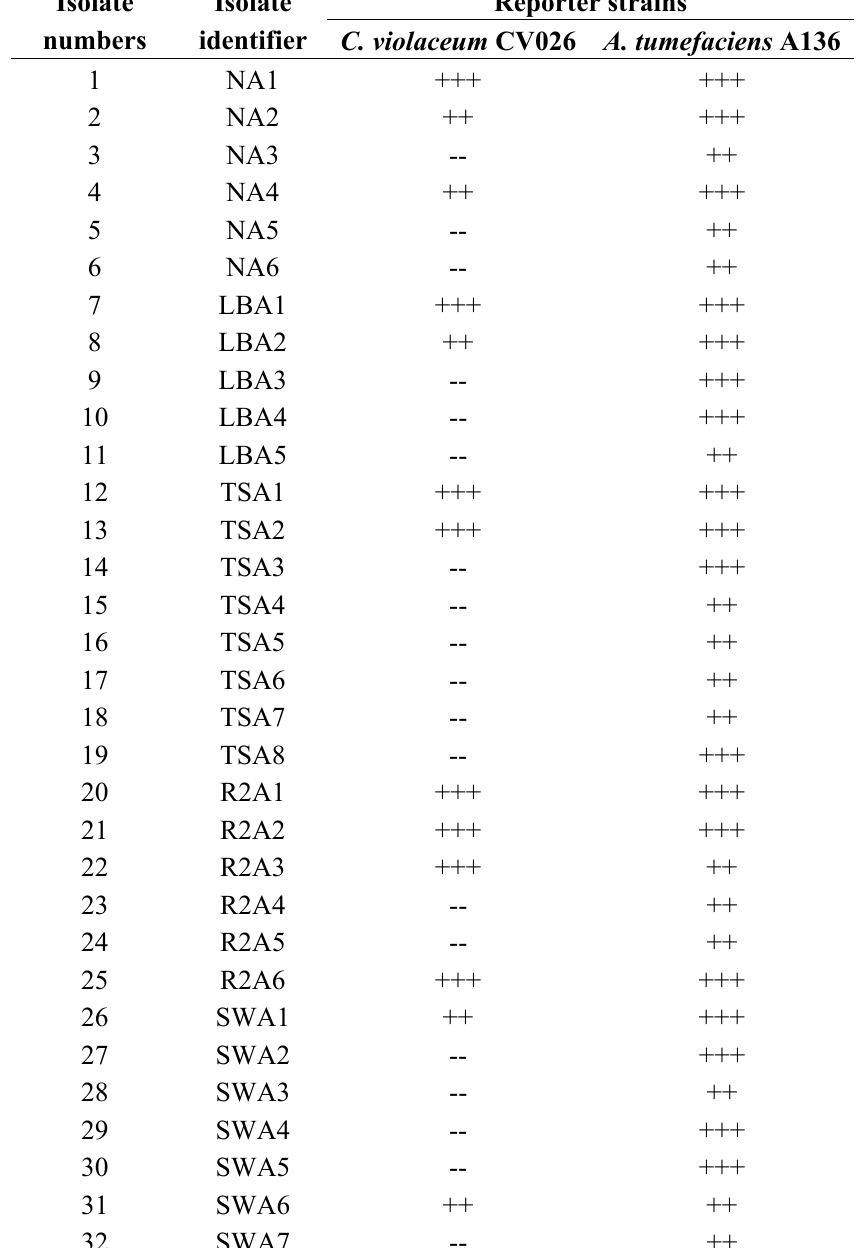
Table 1. Screening of bacterial isolates for AHLs production using violacein and β -galactosidase assay with C. violaceum CV026 and A. tumefaciens A136 reporter